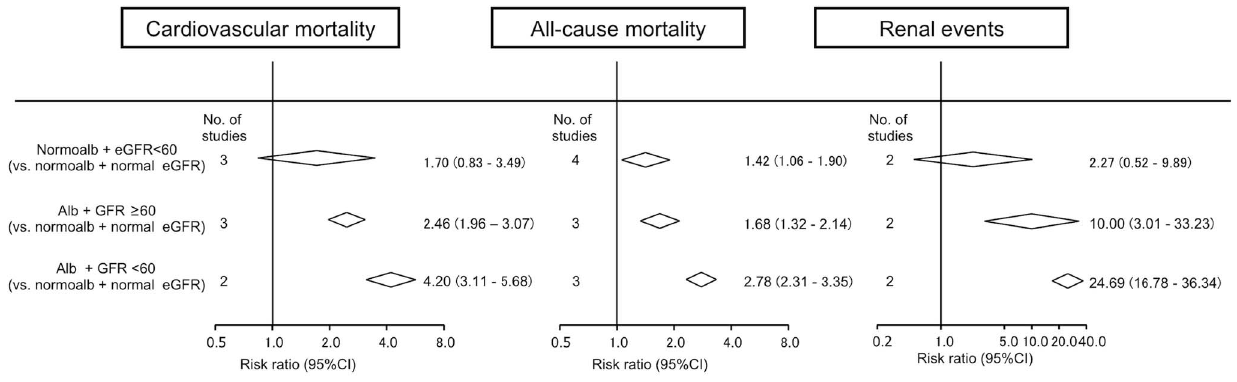
Figure 3. Risk ratio for the association of low eGFR with the risk of each outcome according to the presence of albuminuria, compared with normal eGFR and normoalbuminuria. Albuminuria was defined as any level of albuminuria or pooled estimate of microalbuminuria and macroalbuminuria. Abbreviations: normoalb, normoalbuminuria; alb, albuminuria.